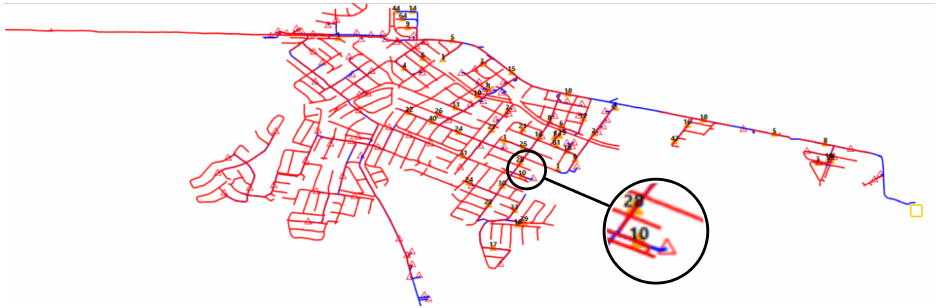
Figure 5. Feeder- α voltage transgression mapping.